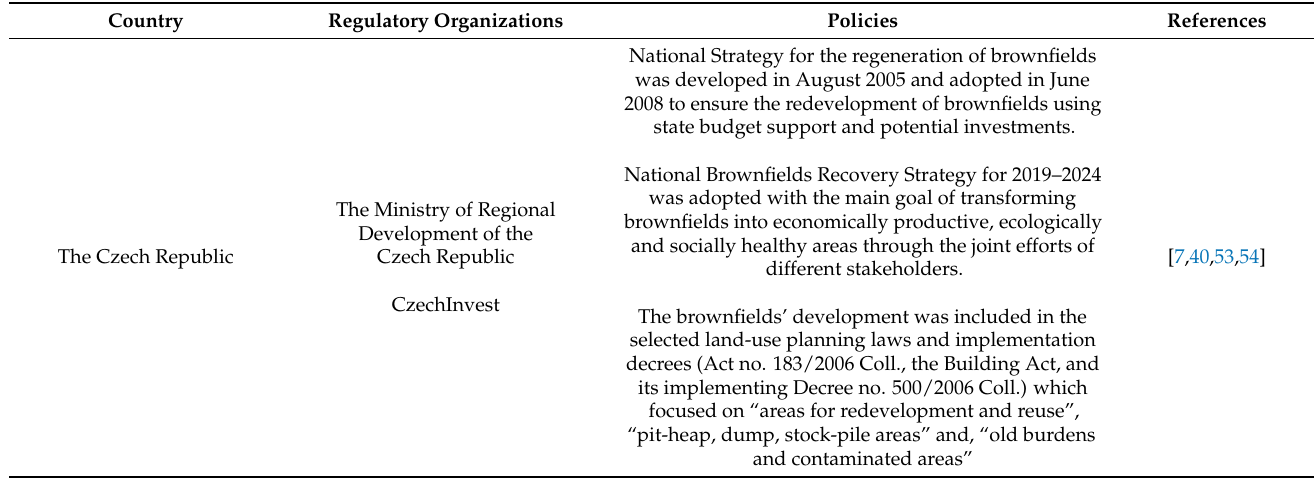
Table 4. Regulatory organizations and policies on brownfield regeneration in the targeted